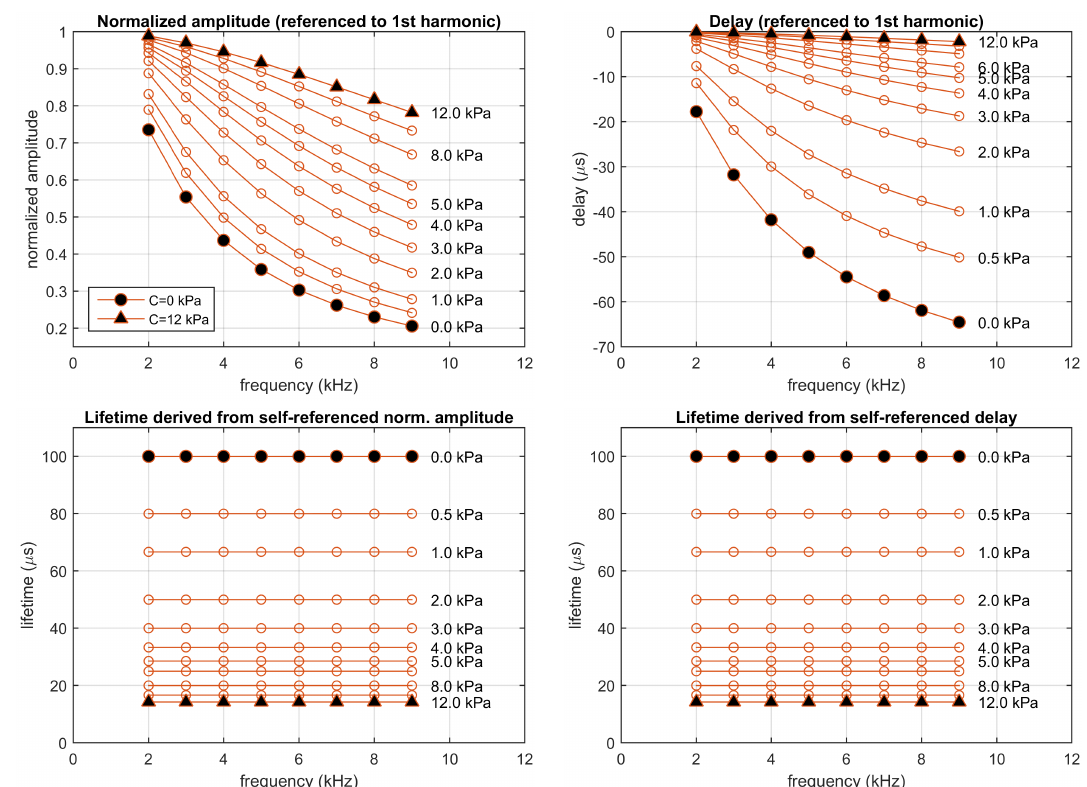
Figure 3. Simulation of a monoexponential luminescent system ( M 0 = 1, τ 0 = 100 µ s, and k = 0.5 (kPa) − 1 ), excited with rectangular pulses of amplitude 1.0 a.u. presented at 1 kHz with 10% duty cycle. Top panels: Normalized amplitudes and delays referenced to the first harmonic; bottom panels: corresponding self-referenced lifetimes. Each point correspond to one harmonic (from 2nd to 9th). Simulations performed at concentrations 0, 0.5, 1, 2, 3, 4, 5, 6, 8, 10, and 12